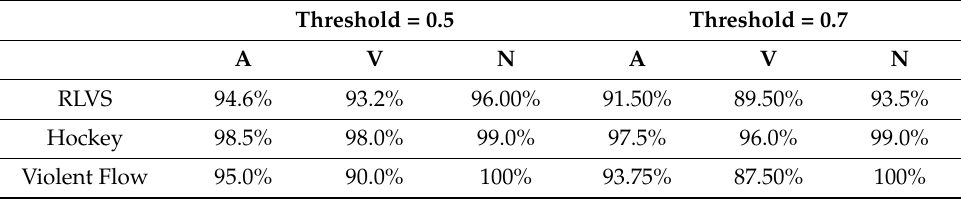
Table 7. The relationship between recognition rate and threshold.